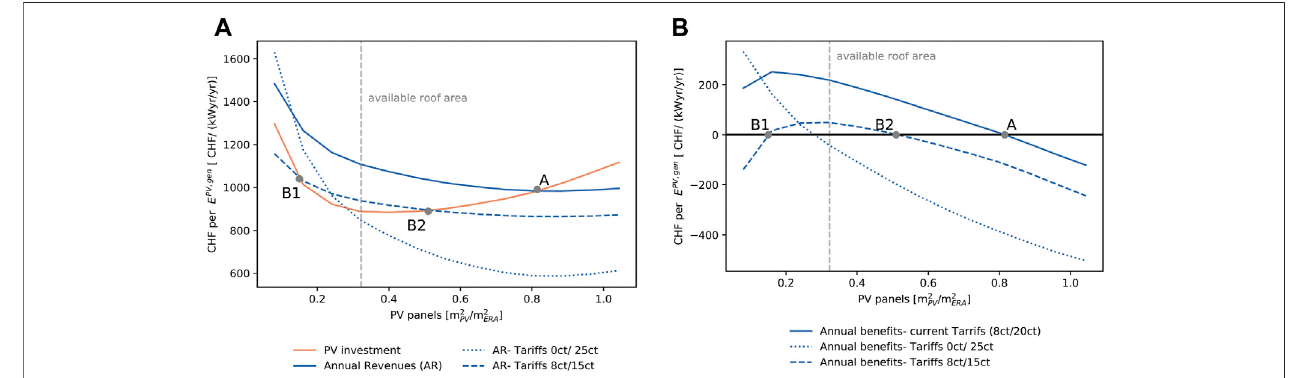
FIGURE7|(A) PVinvestmentper generated PVelectricity E PV , gen and implicit revenuesfordifferentfeed-in/demand prices. Economicpoint: investment inPVand connected revenues are balanced. Point A: current tariffs (8 ct feed-in; 20 ct demand price). Points B1 and B2: exemplary tariffs with two break-even points. (B) Annual bene fi ts, which are the annual revenues (AR) subtracted by the PV investment.